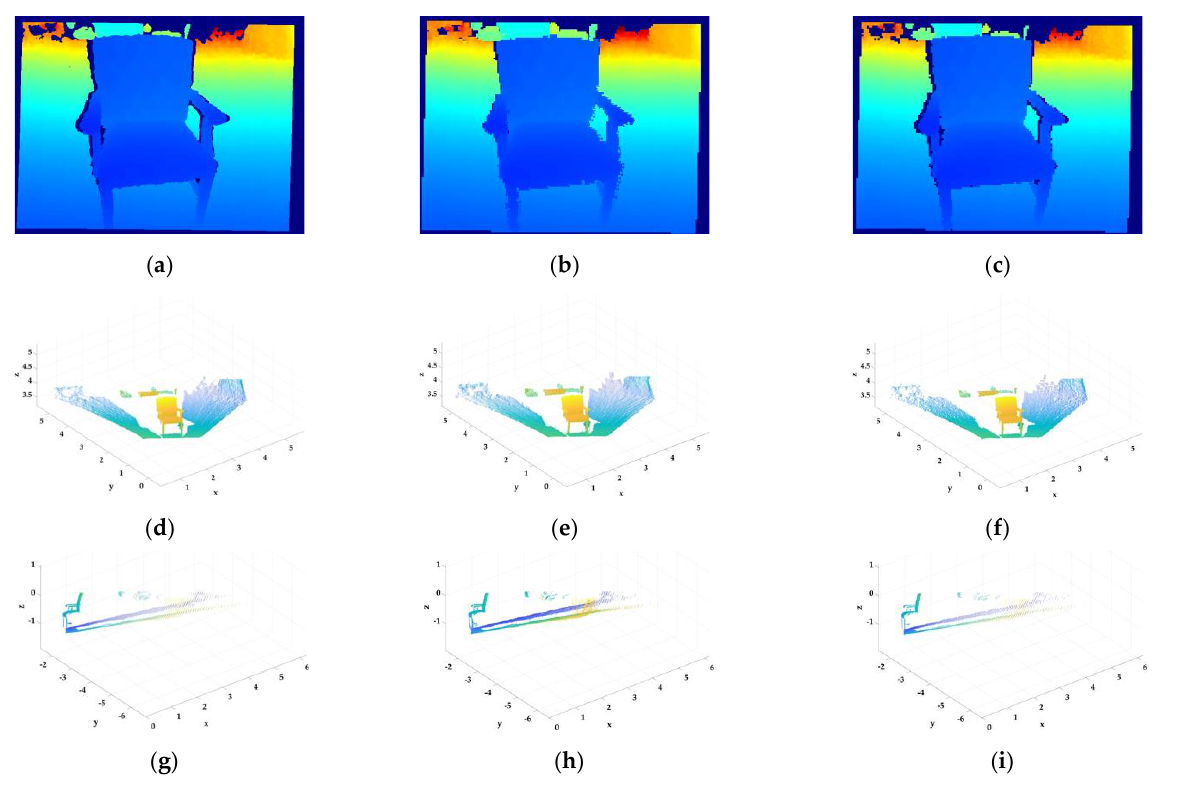
Figure 13. Comparison of details of the Kriging and nearest-neighbour interpolation algorithms.